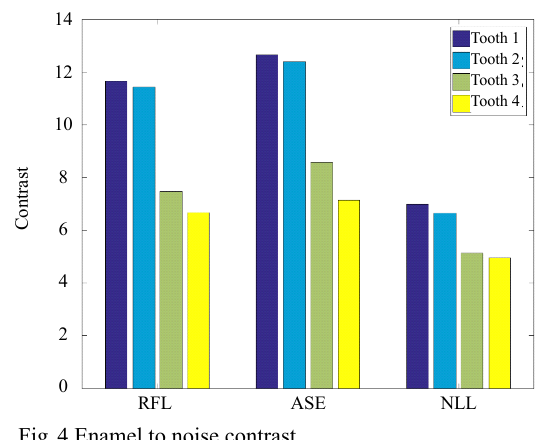
Fig. 4 Enamel to noise contrast.